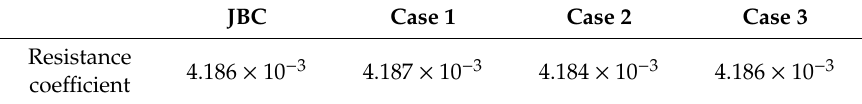
Figure 12. Comparison of pressure distributions around the bow (left: JBC only, right: JBC and deformed hull).